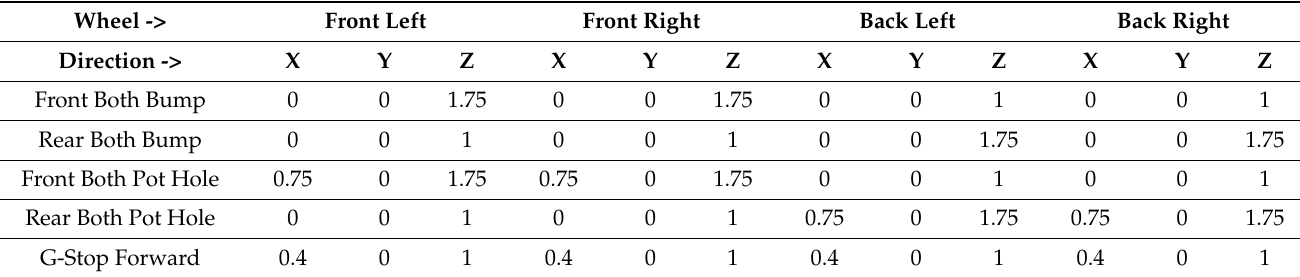
Table 2. Load cases using the method of superposition (numbers indicate g-force magnitudes). Wheel -> Front Left Front Right Back Left Back